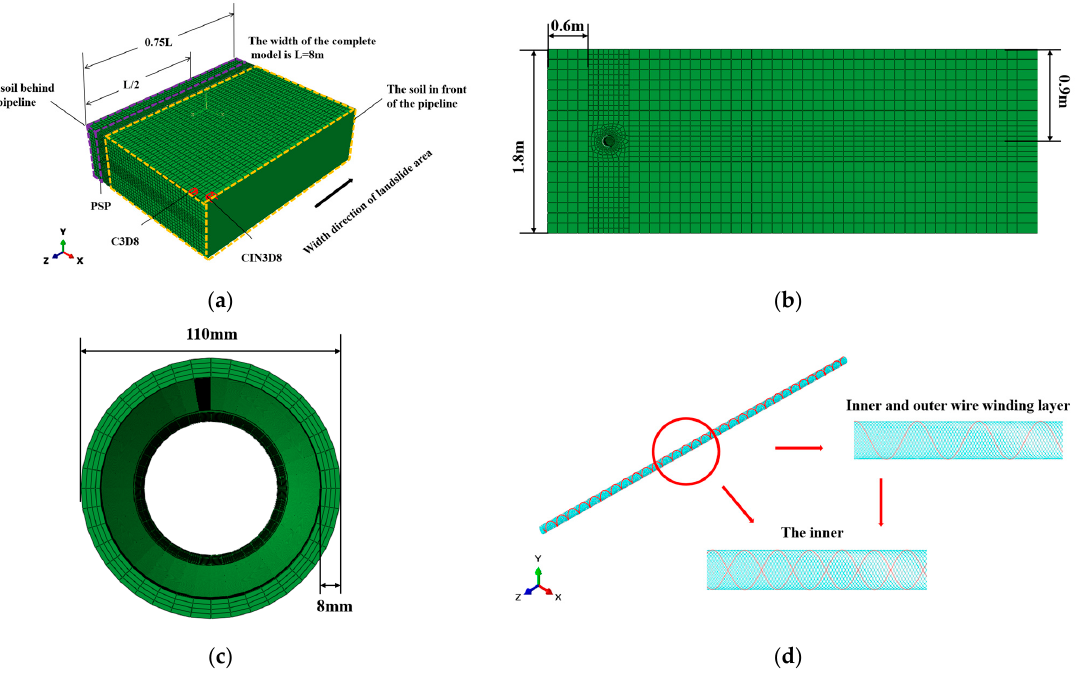
Figure 6. The finite element of the SWW-RTP buried in soil: ( a ) The SWW-RTP–soil model; ( b ) Cross section of soil; ( c ) Cross section of the SWW-RTP; ( d ) steel wires and the HDPE matrix.